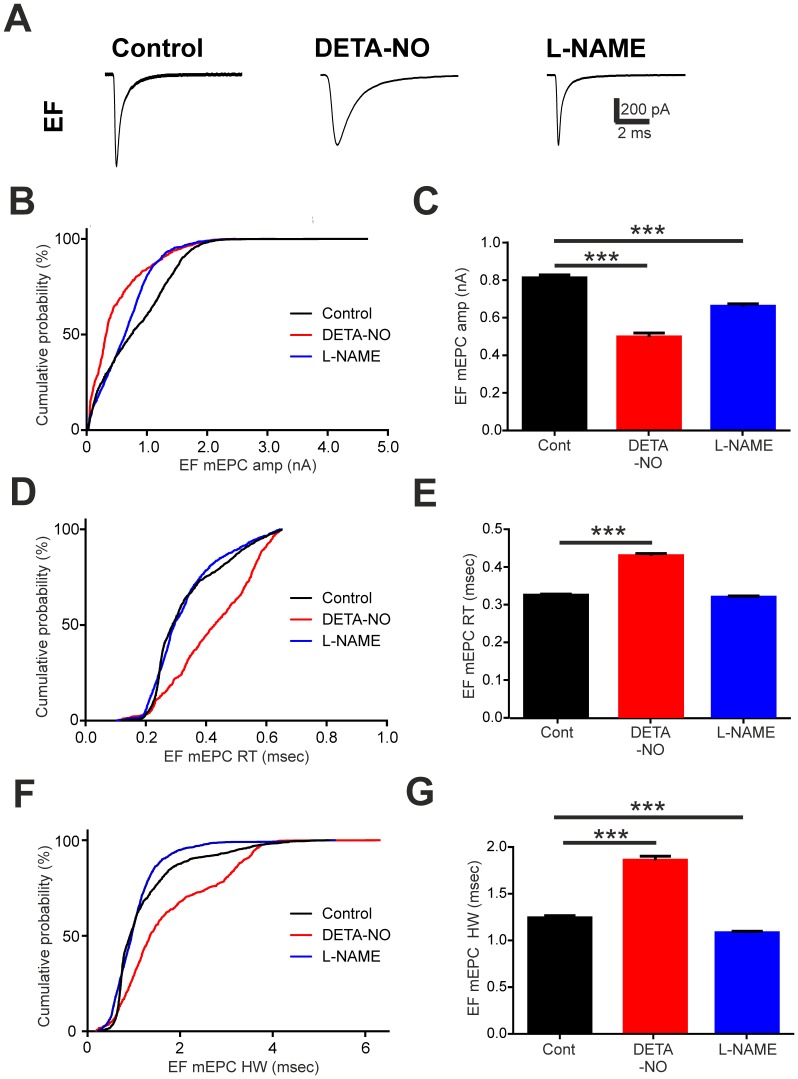
Developmental perturbation of NO signalling affects EF mEPC kinetics.
A. Average traces of miniature end plate currents (mEPCs) captured during recordings of embryonic fast (EF) fibres in control (left), DETA-NO raised (middle) or L-NAME raised (right) fish at 2 days post fertilisation (dpf). B–G. Cumulative percentage plots and bar charts of EF mEPC amplitude (amp, B,C), rise time (RT, D,E) and half-width (HW, F,G) for each experimental condition. Data in C,E,G are represented as mean ± SEM. *** p<0.001.